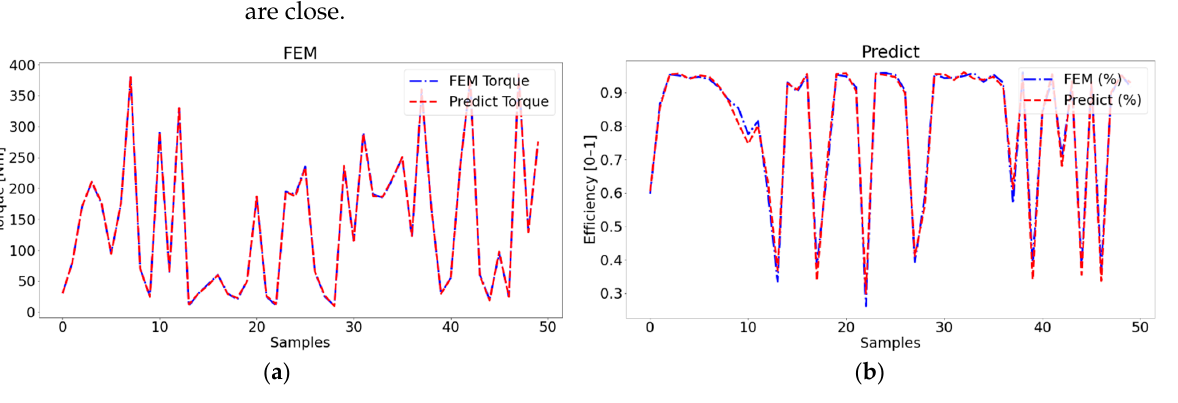
Figure 9. Analyzed motor core loss: ( a ) 2D FEM; ( b ) proposed method.